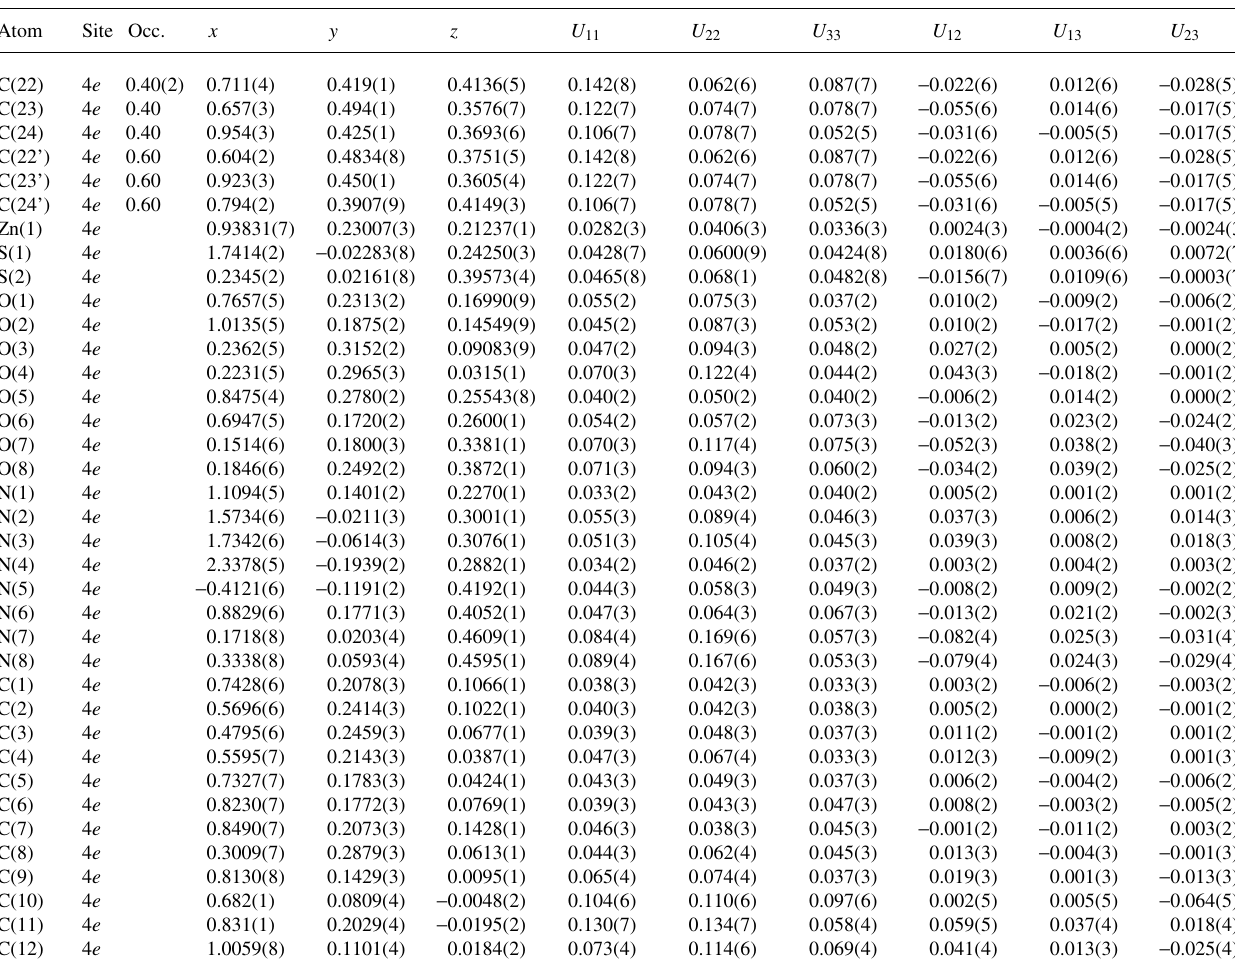
Table 3. Atomic coordinates and displacement parameters (in Å 2 ) .